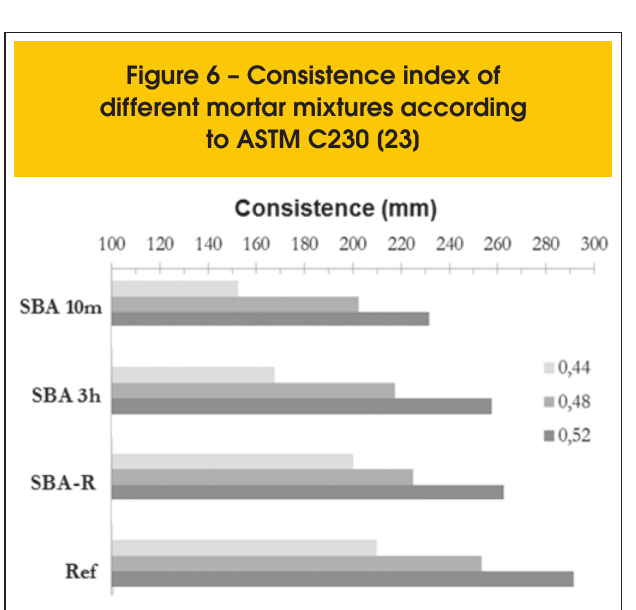
Figure 6 – Consistence index of